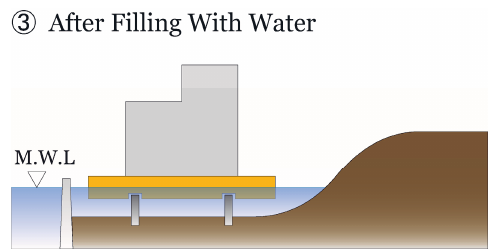
Figure 2. Original land condition and the land condition after removing soil.